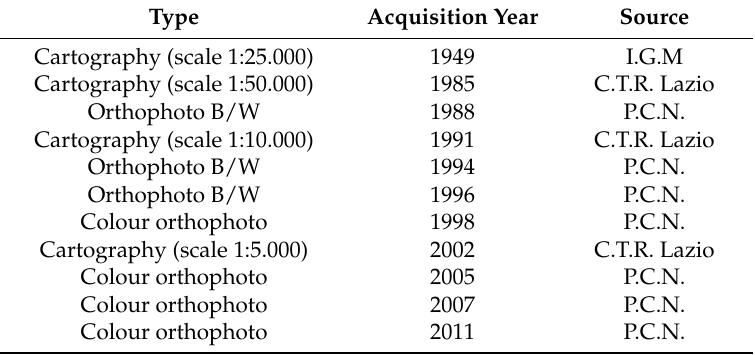
Table 2. List of topographic maps and optical images used to perform manual change detection analysis (sources: I.G.M., Italian Army’s Geographic Institute; C.T.R., official topographic map of the Lazio region; P.C.N., “Geoportal of Italian Ministry of Environment, Land, and